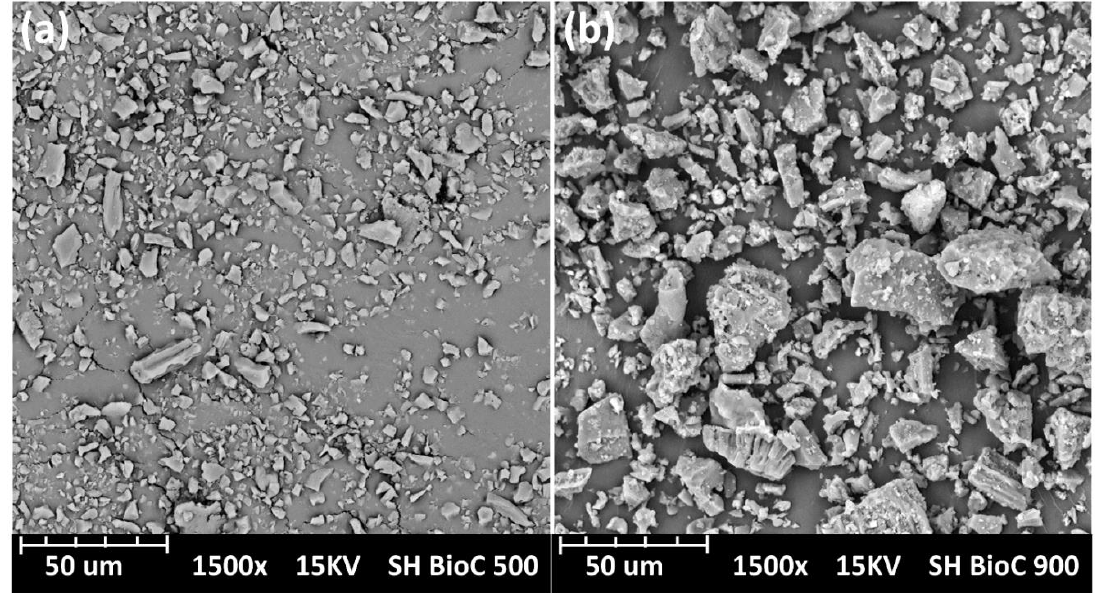
Figure 1. Particle size comparison at different pyrolysis temperatures of soy hull biomass (After ball milling and sieving) ( a ) 500 °C BioC and ( b ) 900 °C BioC.